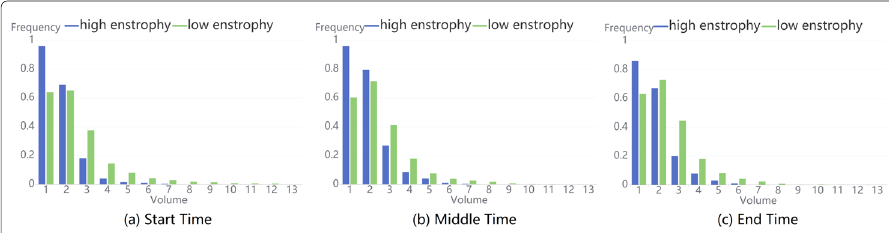
Fig. 2 The frequency histogram for the volume of the components at different levels of enstrophy value during different time of combustion. a Start time. b Middle time. c End time